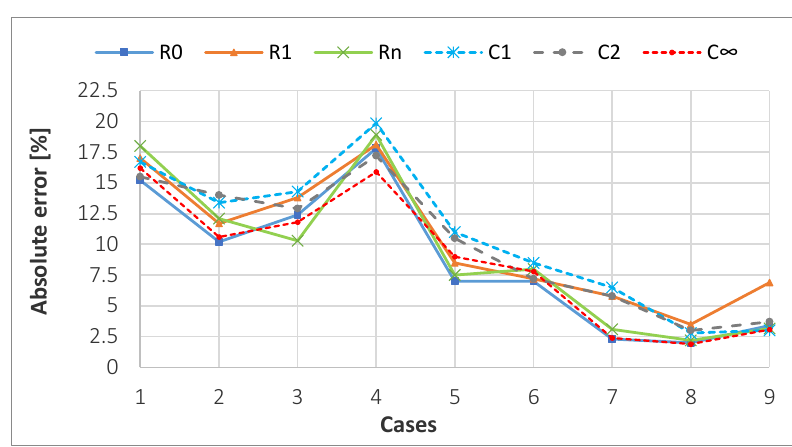
Figure 15. Error plot of Li-Ion battery for each frequency regions.